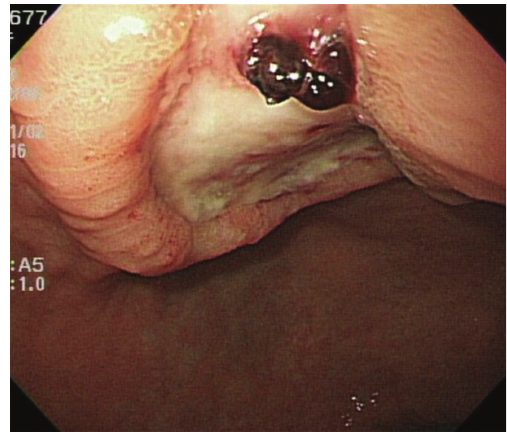
Figure 2: Endoscopic appearance of post-ESD ulcer with apparent exposed